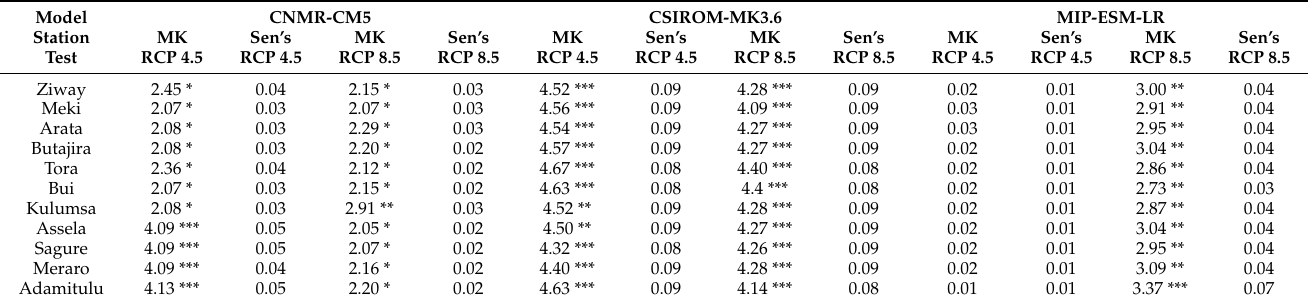
Table A8. Projected Mann–Kendall trend and Sen’s slope estimator results of annual mean T max for 11 stations over Ziway Lake Basin from the period 2050–2072.